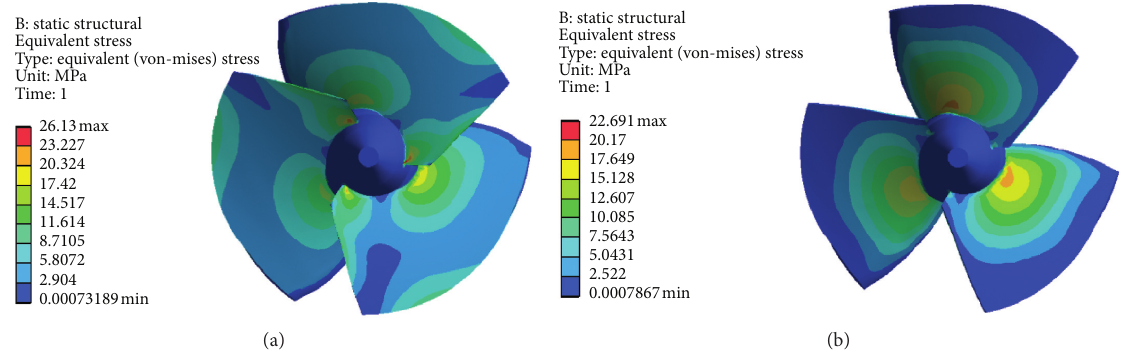
Figure 18: Static stress cloud of the blade before and after optimization: (a) before optimization; (b)